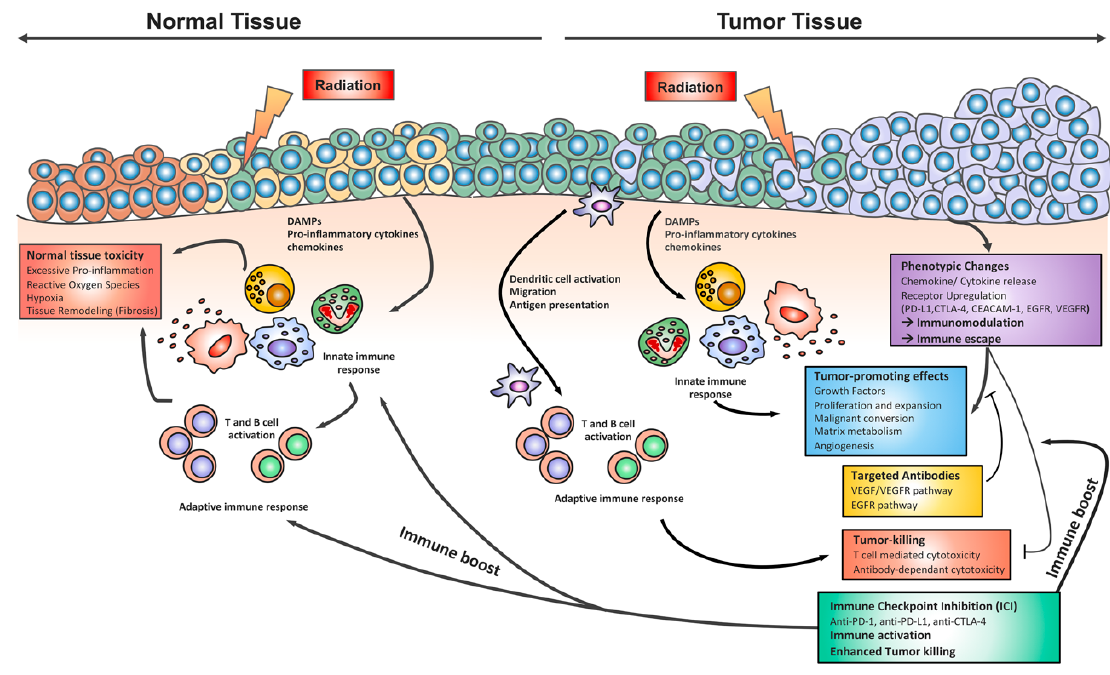
Figure 1. Radiotherapy of malignancies in the thoracic region results in stress, damage and cell death in the tumor tissue, and to some extent also in surrounding normal tissue within the radiation field. The release of damage-associated molecular patterns (DAMPs), cytokines and chemokines leads to the recruitment of immune cells to the site of damage. In the normal lung tissue, the influx of pro-inflammatory immune cells can induce an acute normal tissue-toxicity (pneumonitis) with excessive inflammation, or on the long-term, chronic inflammation, environmental changes and tissue remodeling (fibrosis). In contrast to that, the innate immune system contributes to tumor progression due to tumor-promoting activities. Radiation-induced cell death of tumor cells also results in the release of tumor antigens to activate dendritic cells with subsequent antigen presentation and induction of T cell-mediated tumor killing, a process termed “in situ vaccination”. However, several tumor-intrinsic mechanisms shape the innate immune response towards tumor promotion and adaptive immune responses towards immunosuppression, so that the tumor cells escape from T cell-mediated cytotoxicity. The use of immune checkpoint inhibition (ICI) boosts the immune system, overcoming immunosuppression and immune escape, and thus leading to successful eradication of tumor cells. In normal tissues, ICI might trigger an unbalanced immune activation, thereby potentially enhancing normal tissue toxicity. Combined treatment with ICI and radiotherapy bears the potential risk of synergistic toxic effects, depending on several variables in the treatment setting of radioimmunotherapy.